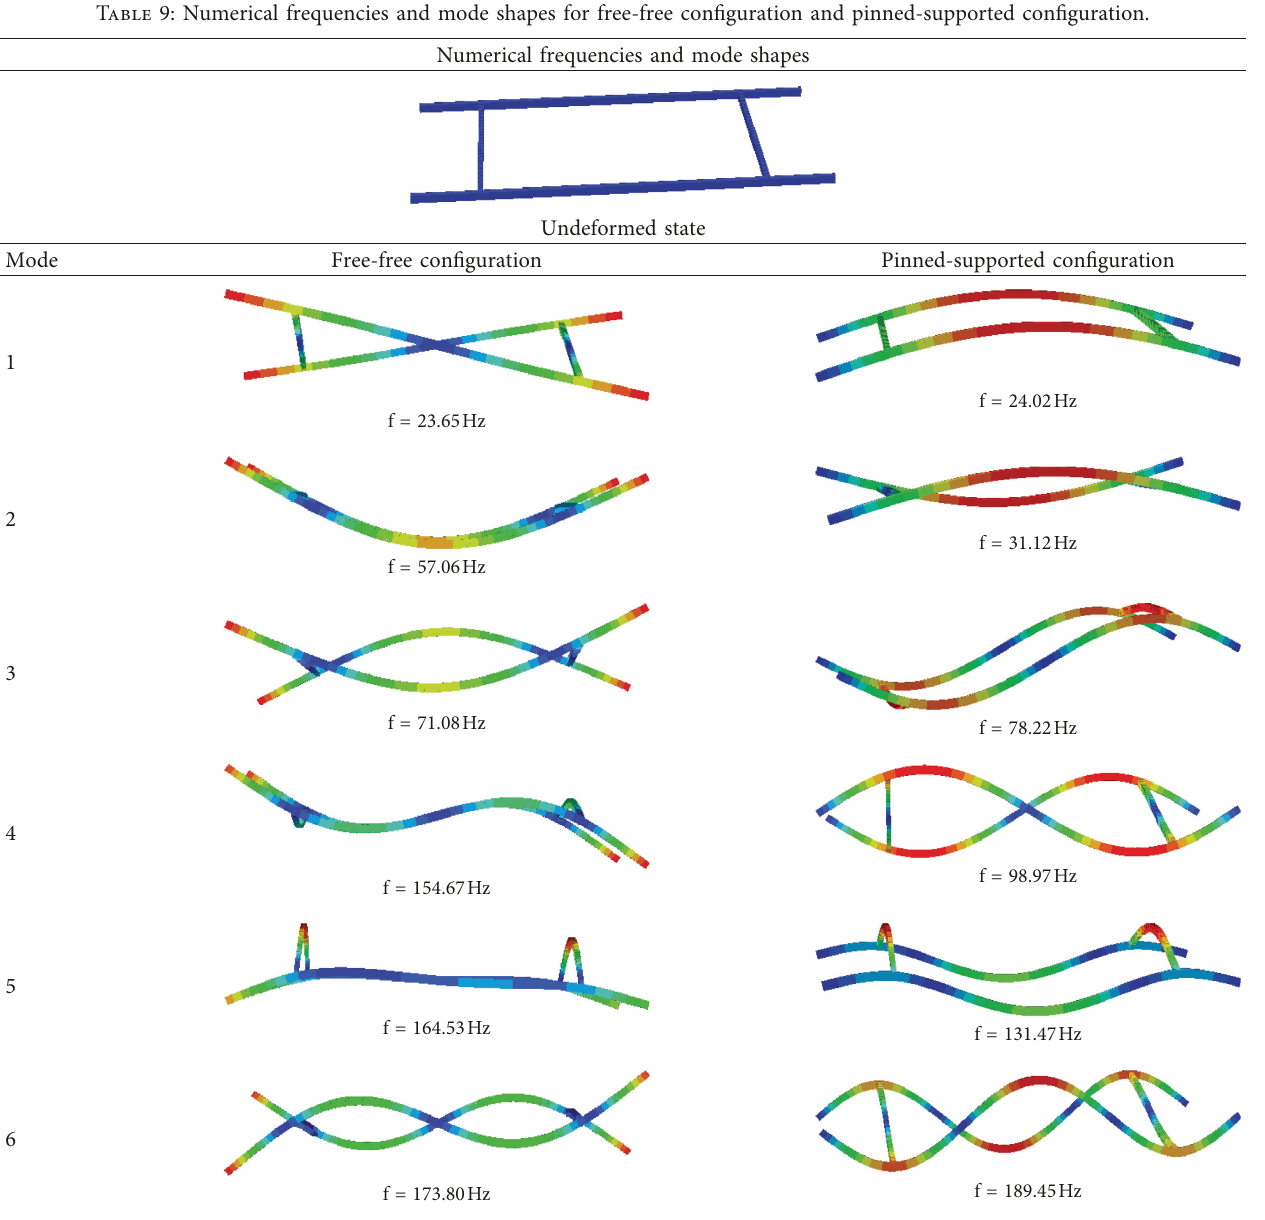
Table 9: Numerical frequencies and mode shapes for free-free configuration and pinned-supported configuration.